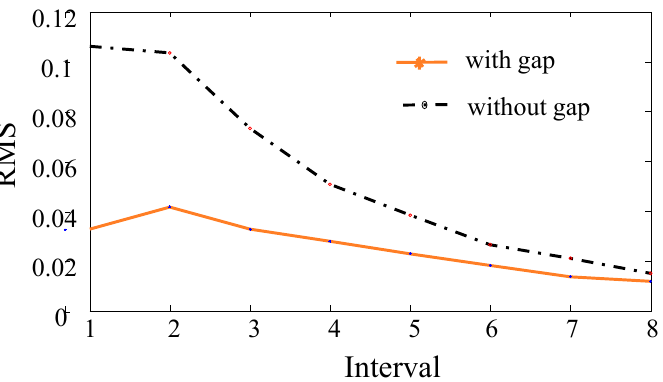
Figure 12. RMS of AE signals at eight 1 ms intervals for joints with normal and low bonding strength.